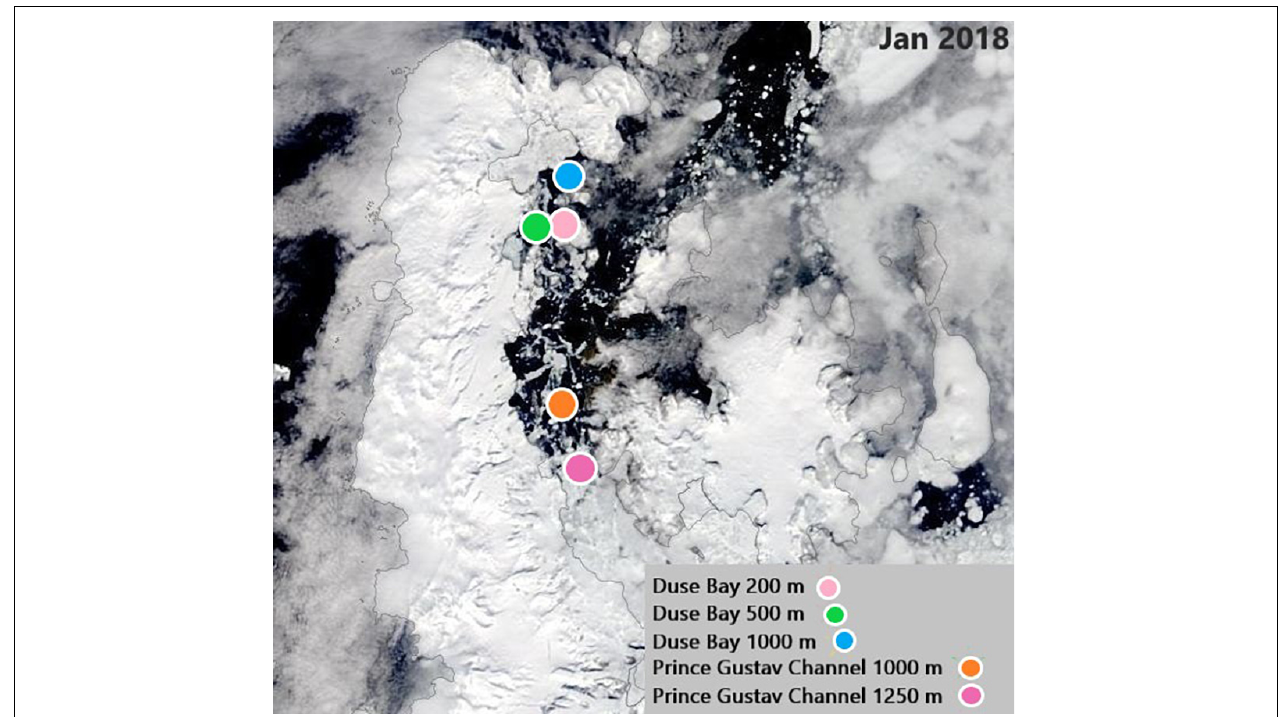
FIGURE 7 | Satellite image of the sampling Area in January 2018, with PGC 1250 still covered by sea-ice while the rest of the stations are ice-free. The different colors indicate each station in the PGC and DB, as shown in the legend. Satellite images source: https://worldview.earthdata.nasa.gov.